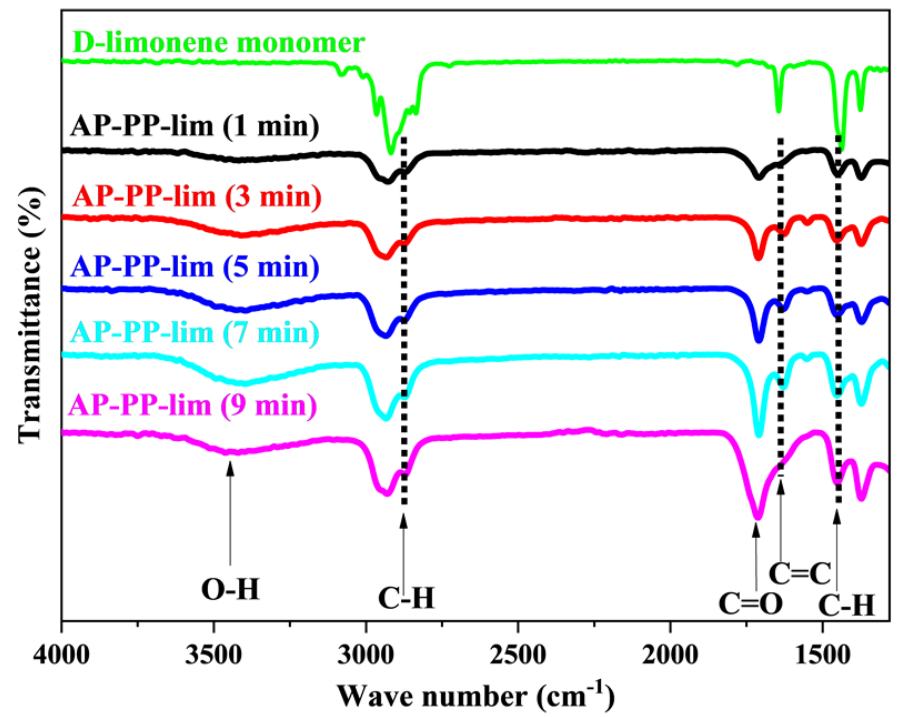
Figure 3. ATR-FTIR spectra of D-limonene monomer and AP − PP − lim deposited on a glass substrate at plasma polymerisation times of 1, 3, 5, 7 and 9 min.